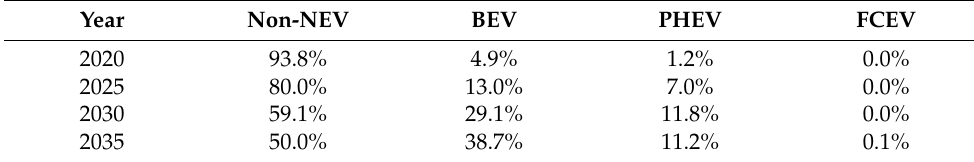
Table 4. Forecast of the proportion of sales of passenger vehicles by fuel type.